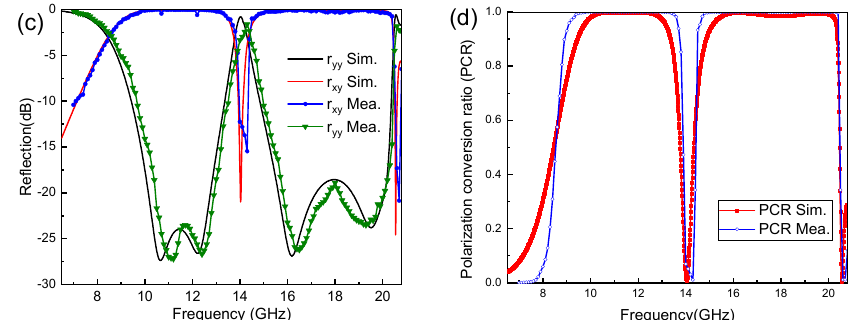
Figure 9. ( a ) Photograph of the prepared sample. ( b ) Schematic diagram of the measuring device. ( c ) Experimental and simulated cross- and co-polarized reflections. ( d ) Polarization conversion ratio.